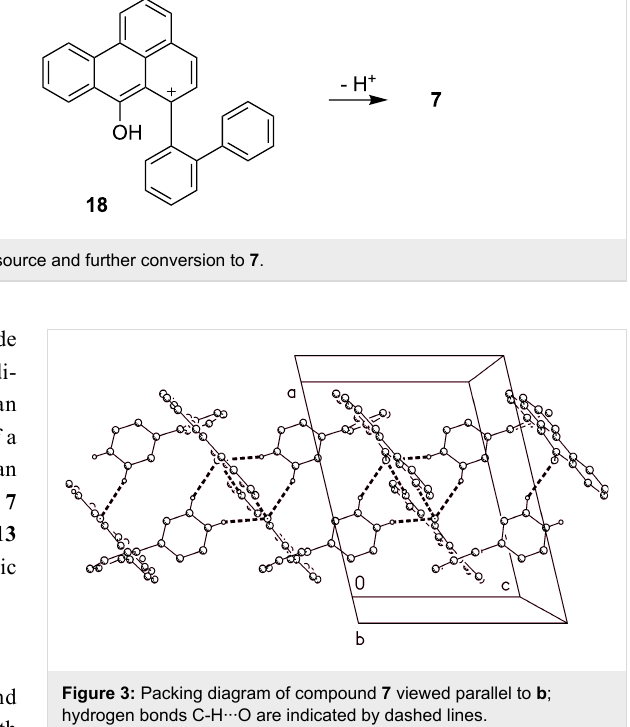
The main ring system (including the oxygen atom, but excluding C5 and C6) is reasonably planar, with a rmsd of 0.074 Å; the rings C18-23 and C19-24 are essentially coplanar (interplanar angle 3.9°). Despite the presence of the hydroxyl group, there are no classical hydrogen bonds; instead, the OH hydrogen is directed towards the ring centroid of C18-23 (H···centroid 2.74 Å, angle 163°). The packing involves